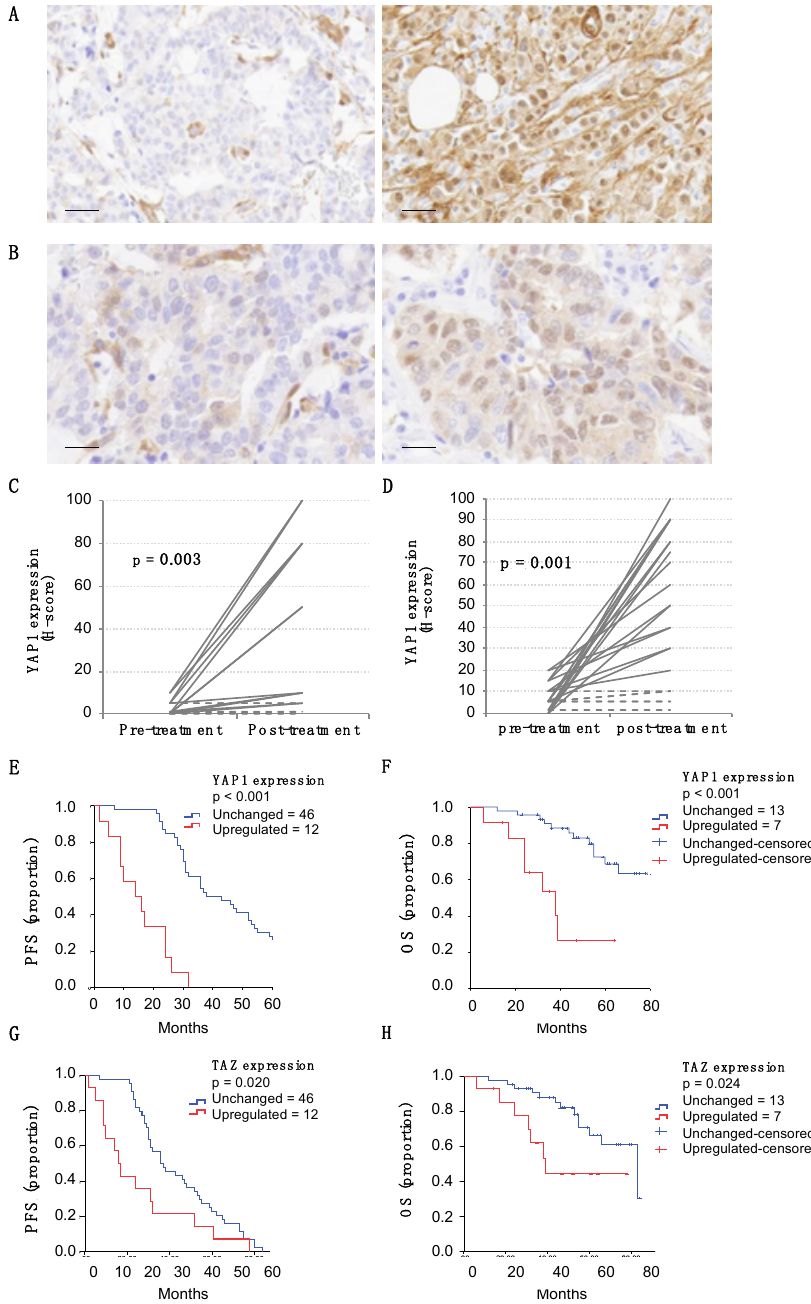
Figure 7. YAP1 expression impacts clinical significance in metastatic HER2 breast cancer patients and on trastuzumab resistance. ( A ) Representative IHC images of YAP1 staining from tumoral samples from two different breast cancer patients. Bar: 50 µm. ( B ) Representative IHC images of YAP1 staining from a paired sample, before and after treatment with trastuzumab (pre- and post-therapy). The percentage of tumor cells positively stained for YAP1 was estimated in 10% and 80%, respectively. Bar: 50 µm. ( C ) YAP1 expression levels in pre- and post-treatment settings in metastatic cases; n = 19. Dashed lines represent cases with no significant variation. ( D ) Id. in neoadjuvant setting; n = 24. ( E ) Kaplan-Meier analysis of PFS and ( F ) OS in the cohort of 58 HER2-positive metastatic breast cancer patients. YAP1 overexpression (dashed line) was associated with lower PFS ( p < 0.001) and OS ( p < 0.001). ( G ) Kaplan-Meier analysis of PFS and ( H ) OS in the same cohort of 58 HER2-positive metastatic breast cancer patients with respect to TAZ overexpression (dashed line). TAZ was associated with lower PFS ( p = 0.020) and OS ( p =